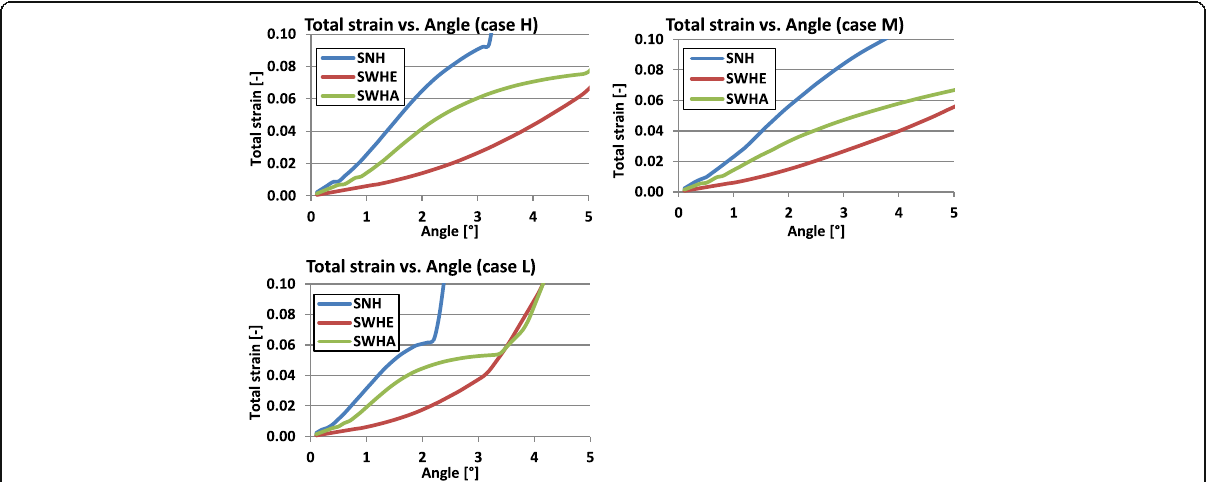
Fig. 19 Total strain versus opening angle calculated with nonlinear 2D FEA: The total strain increased faster for the specimen with no hole